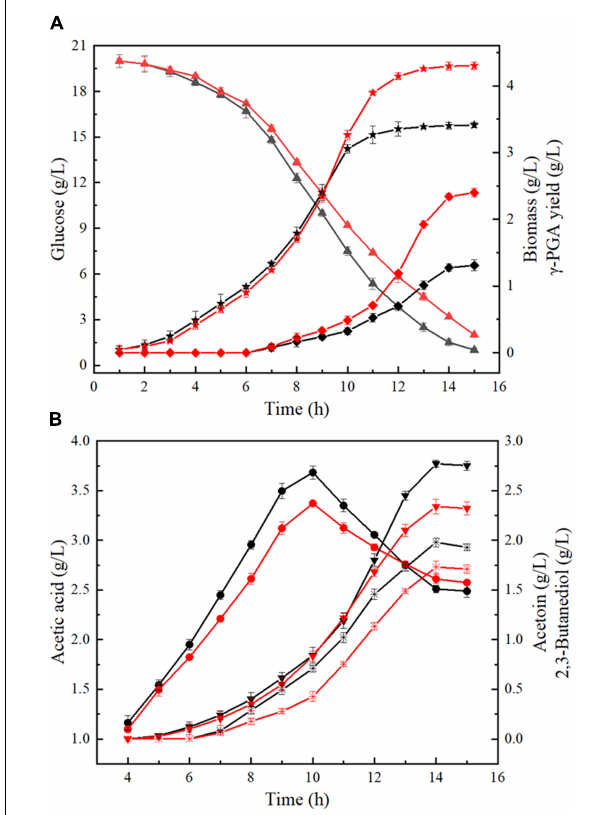
FIGURE 3 | Fermentation process curves of WX-02/pHY300 and WX-02/pHY- dltB . (A) Biomass, glucose concentration, and γ -PGA yield. (B) Acetic acid, acetion, and 2,3-butanediol yields. The solid black line indicates the control strain WX-02/pHY300, and the red solid line represents the recombinant strain WX-02/pHY- dltB . Triangle, glucose; pentagram, biomass; diamond, γ -PGA; circle, acetic acid; inverted triangle, 2,3-butanediol; fork,